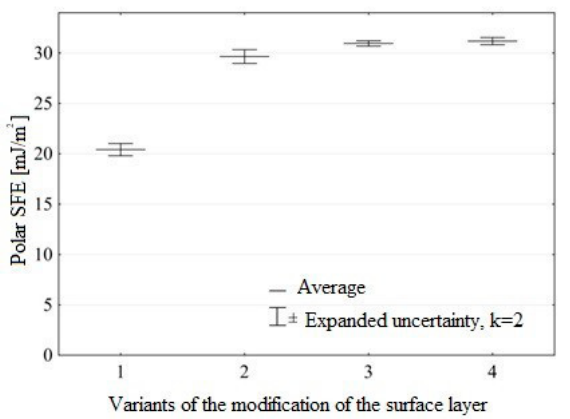
Figure 14. Polar component SFE of Ti6Al4V titanium alloy for different ozone treatment conditions (modification variants of surface layer are described in “Materials and Methods”).